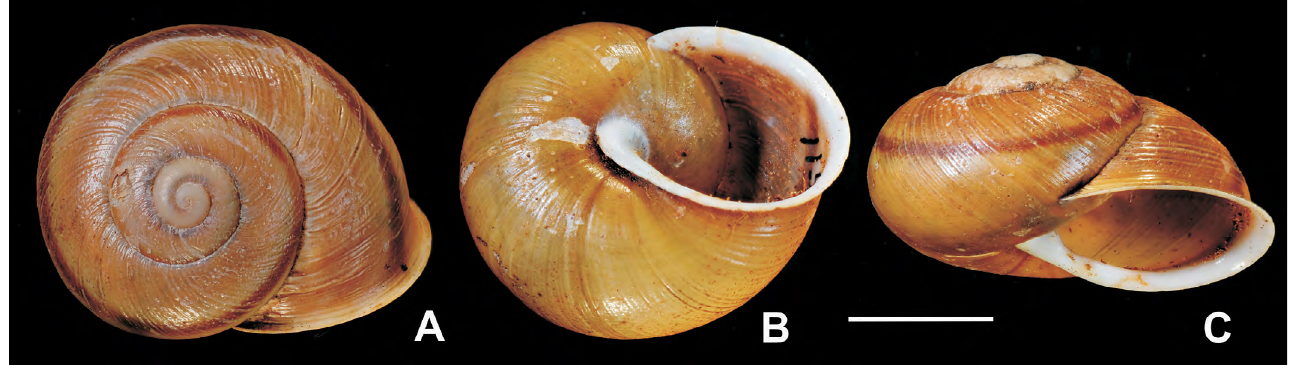
Figure 1. Shell of Epiphragmophora estella . A. Dorsal view. B. Ventral view. C. Lateral view. Scale bar = 5 cm.